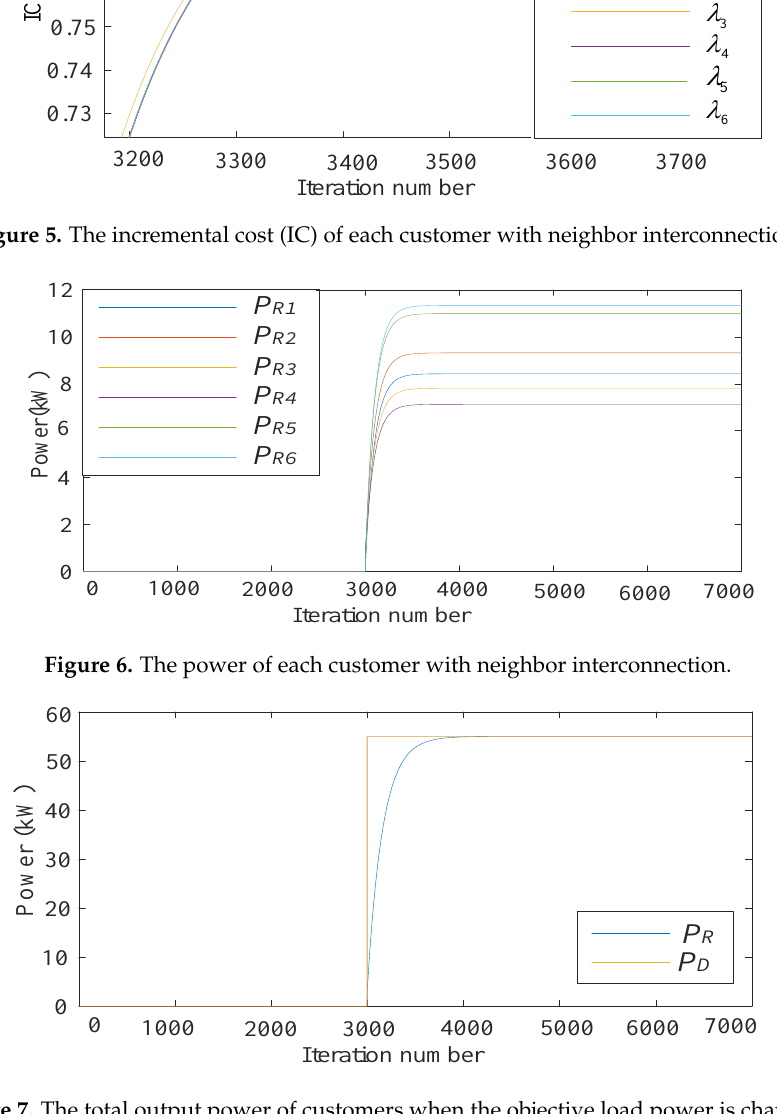
Figure 7. The total output power of customers when the objective load power is